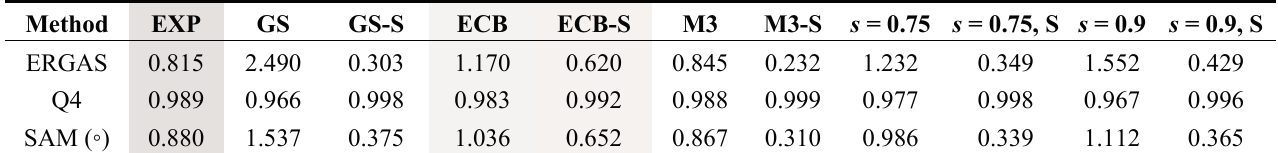
Table 5. Quantitative comparison of the fusion results after degrading the images into the LR resolution, i.e ., at 2.4 m, to check the consistency property of the Wald’s protocol for the QuickBird dataset at full scale.